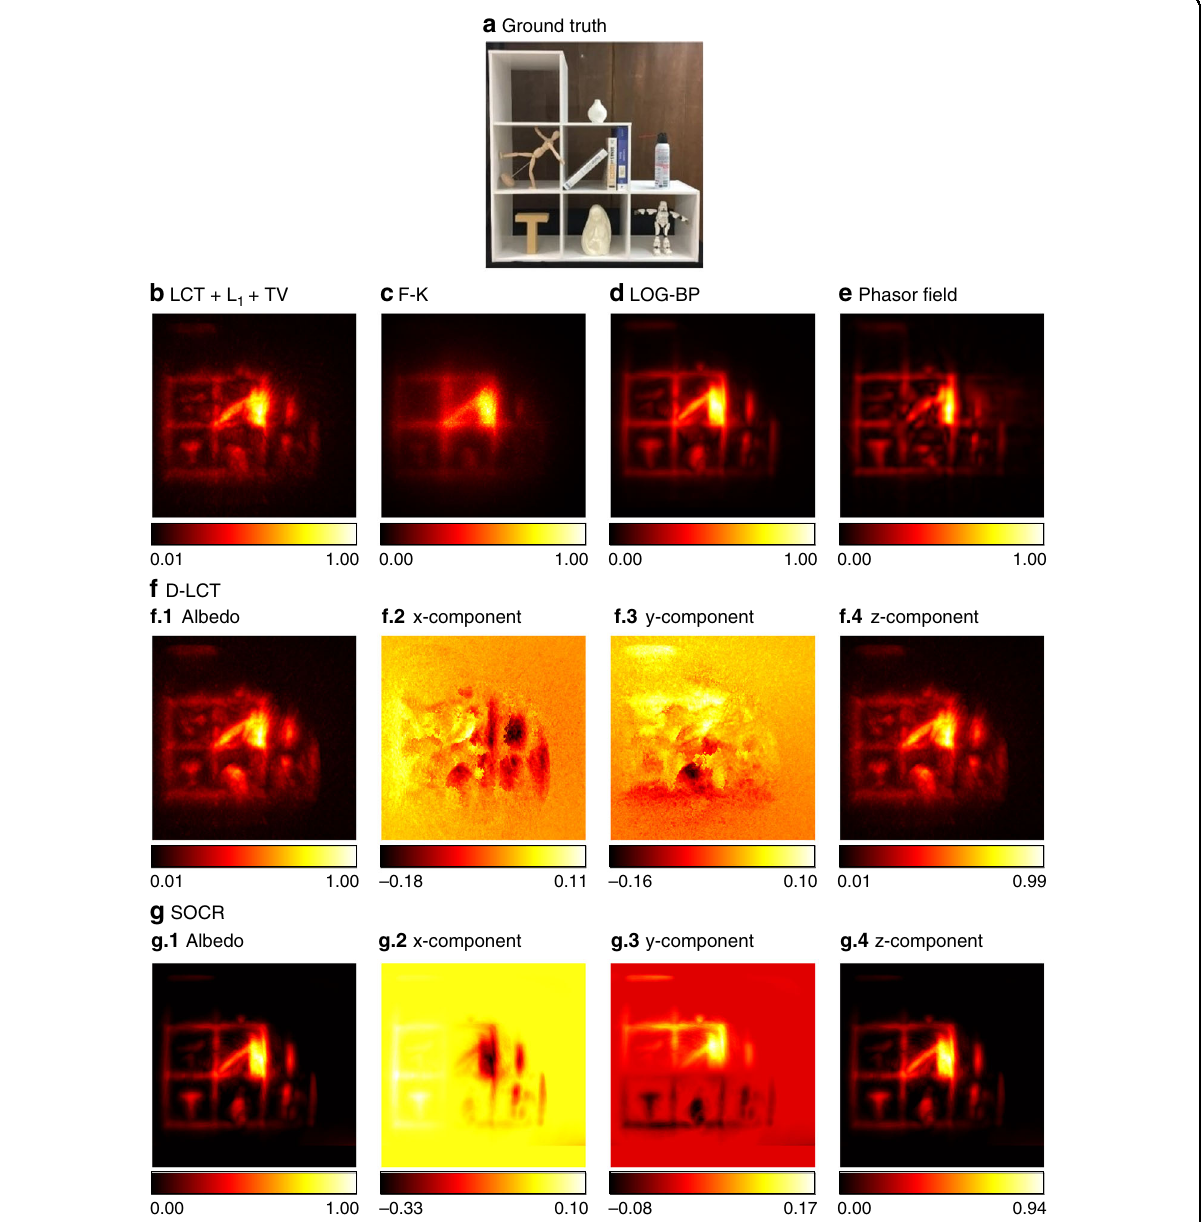
Fig. 13 Reconstruction results of the shelf with lights on (non-confocal, 390 min). The ground truth is shown in a . Reconstructions are shown in b – g . The hidden scene is measured under strong ambient light. Both the LOG-BP method and the SOCR algorithm reconstruct the targets well, while SOCR also reconstructs the surface normal of the hidden